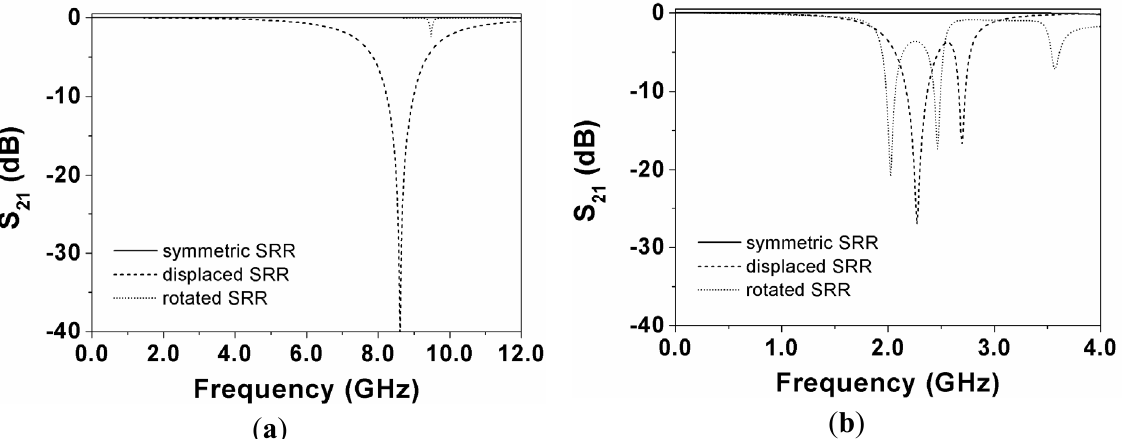
Figure 5. Simulated transmission coefficients of the structures of Figure 4 and those obtained by displacing 0.5 mm and rotating 10° the SRR; ( a ) Figure 4(a) and ( b ) Figure